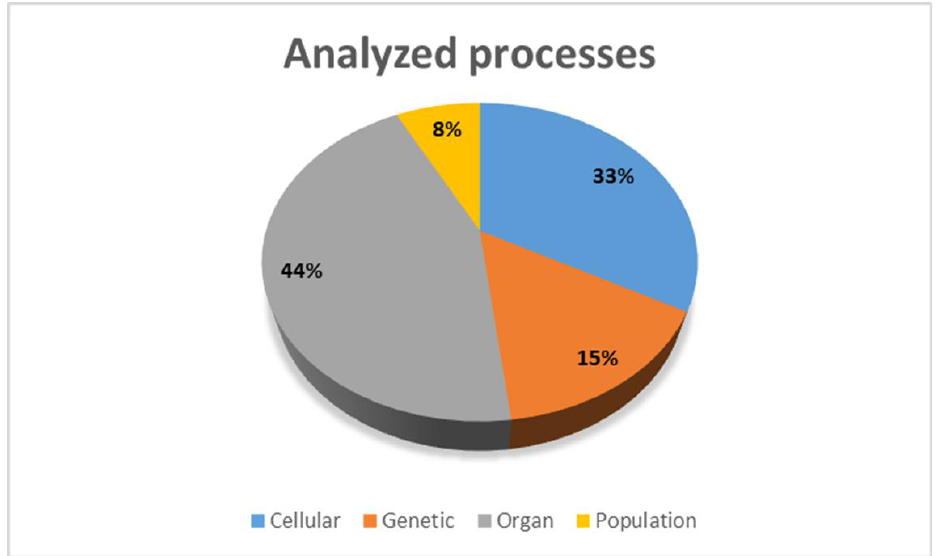
Figure 4. Pathophysiological processes analyzed in the reviewed studies. One study may have investigated more than one process. The majority of the studies investigated organ (44%) and cellular level (33%) processes. Genetic level analysis was pursued in 15% of the studies, while general characteristics of patient populations with persistent AF were investigated in 8% of the studies.